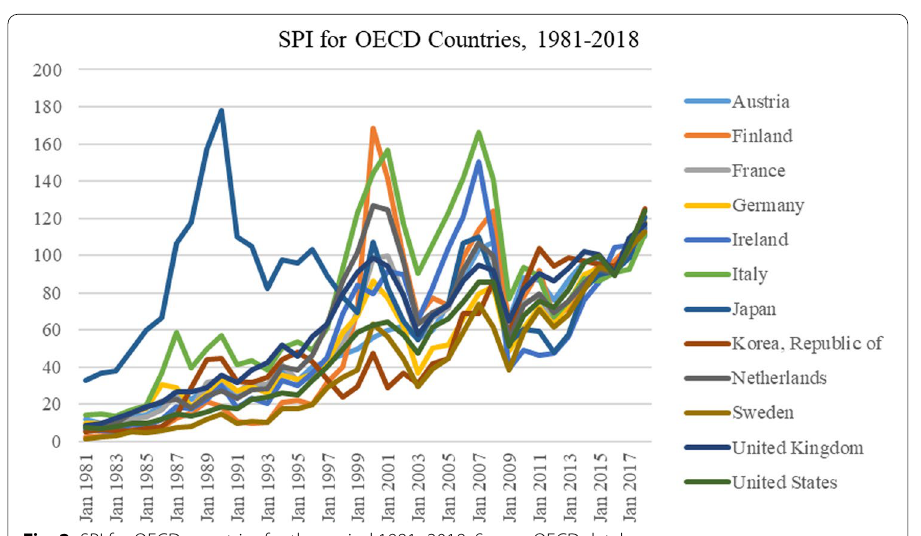
Fig. 2 SPI for OECD countries for the period 1981–2018. Source : OECD